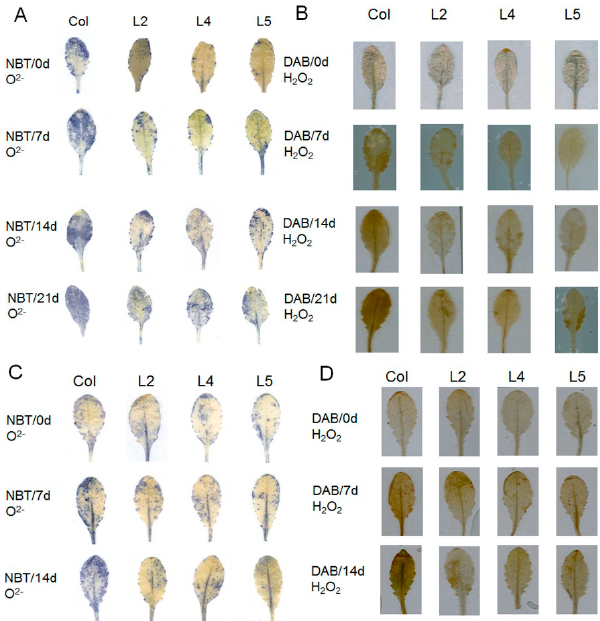
Figure 6. In situ ROS generation in SpCIPK26 -OXP and WT subjected to drought and salt stress: ( A , C ) O 2 − contents in plants treated with drought and salt, respectively; and ( B , D ) H 2 O 2 detection of plants treated with drought and salt, respectively. Stress was processed as depicted in Figure 3. O 2 − was detected by nitro-blue tetrazolium (NBT) reduction and H 2 O 2 was detected by diaminobenzidine (DAB) at specific time points. Samples were taken on the 7th, 14th and 21st days for drought and at the 7th and 14th for salt, and samples at the start of treatments were taken as control (Col). The 4th–6th leaves were taken from every plant. All treatments were replicated three times biologically. L2, L4 and L5 mean three transgenic lines ( SpCIPK26 -OXP).